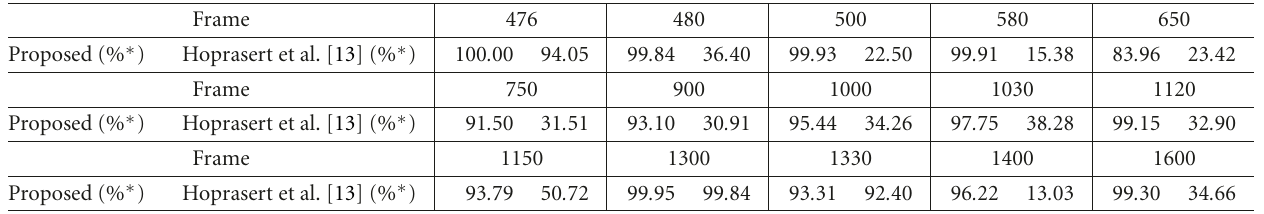
Figure 6: The results of illumination changes with a yellow desk light, the number below the picture is the index of frame, (a) original images, (b) the results of pixel classification, where red indicates the shadow, green indicates the highlight, and blue indicates the foreground, (c) the results of background subtraction with shadow removal using the proposed method, where dark indicates the background and white indicates the foreground. Table 2: The robustness test between the proposed method and that proposed by Hoprasert et al. [13] via local illumination changes with a yellow desk